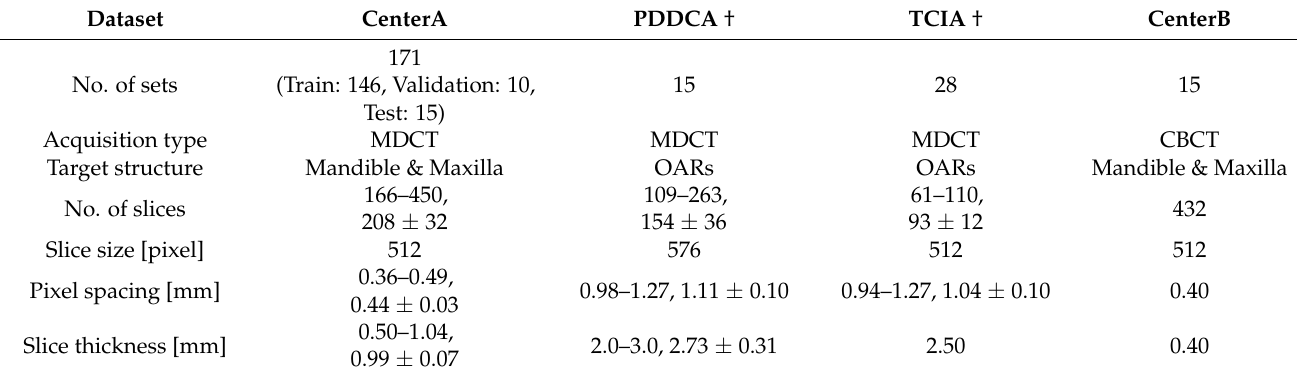
Table 1. Properties of the